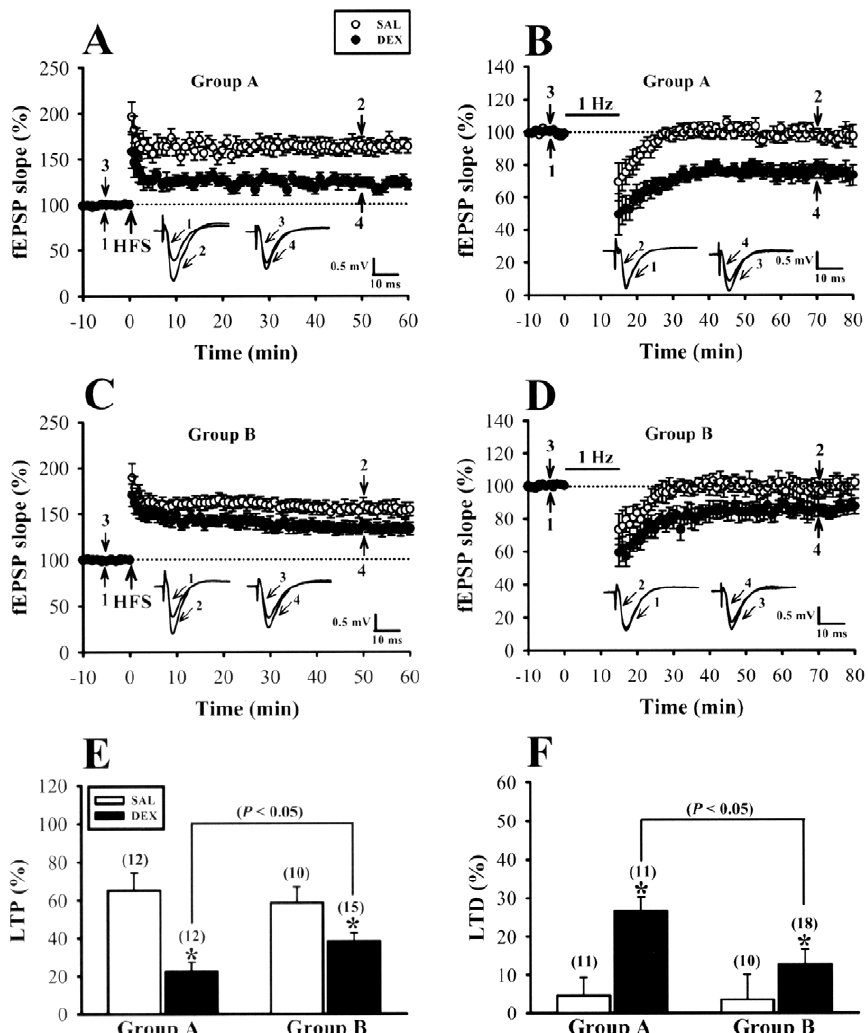
Figure 4. Culling reduces the effects of neonatal DEX treatment on LTP and LTD in hippocampal CA1 region. (A) Summary graphs of LTP induced with a HFS in slices from 5-week-old rats of Group A that received neonatal SAL or DEX treatment. (B) Summary graphs of LTD induced with a prolonged LFS in slices from 5-week-old rats of Group A that received neonatal SAL or DEX treatment. (C) Summary graphs of LTP induced with a HFS in slices from 5-week-old rats of Group B that received neonatal SAL or DEX treatment. (D) Summary graphs of LTD induced with a prolonged LFS in slices from 5-week-old rats of Group B that received neonatal SAL or DEX treatment. (E) Summary bar graphs depicting levels of potentiation measured 50 min after HFS in slices from neonatal SAL- or DEX-treated rats for Group A and Group B. (F) Summary bar graphs depicting levels of depression measured 50 min after LFS in slices from neonatal SAL- or DEX-treated rats for Group A and Group B. The total number of animals examined is indicated by n in parenthesis. Representative traces of fEPSPs were taken at the time indicated by number. Horizontal bars denote the period of delivery of LFS. The dashed lines show the level of baseline. Data represent the mean 6 SEM. *p , 0.05 compared with SAL-treated rats.